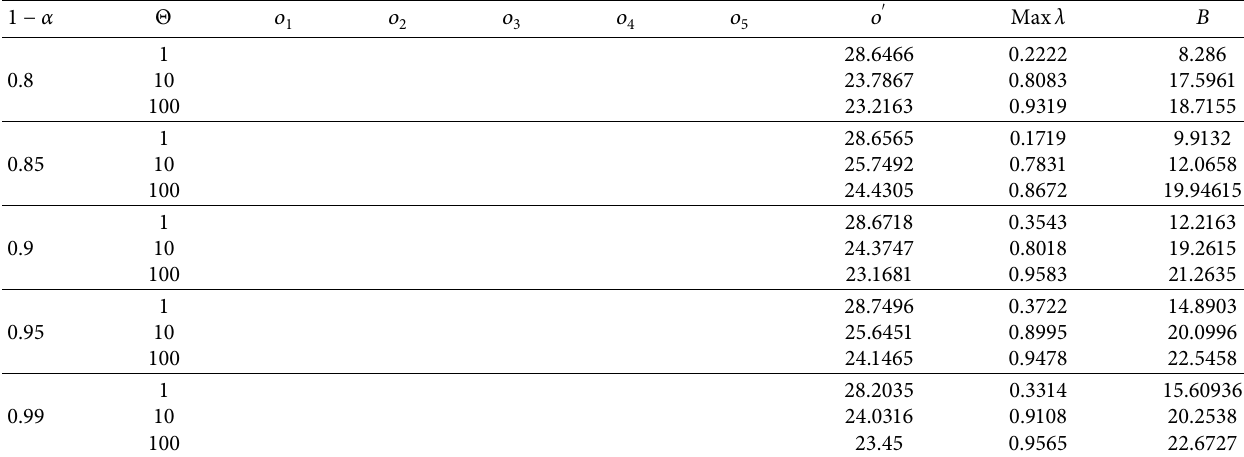
Table 2: Scenario 2: the optimal solution of the model under diferent confdence levels and diferent utility coefcients.